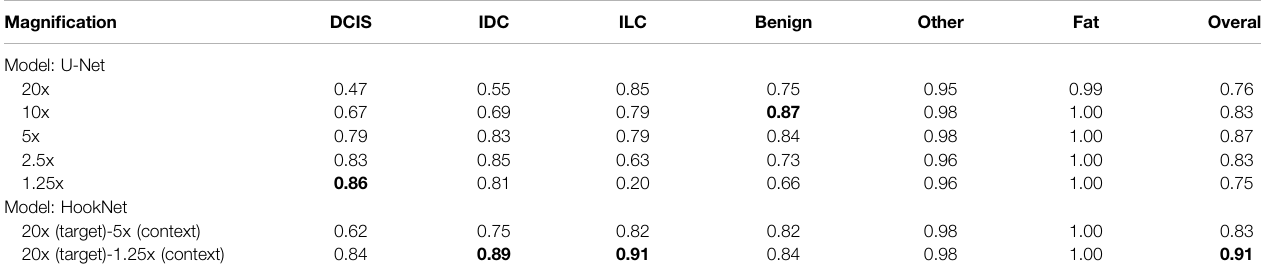
TABLE 5 | Performance of the U-Net (above) and HookNet (below) on the breast dataset. The architectures are compared on the F1 score, for each tissue type (description of the tissue type in the Supplementary Material ). The overall macro-F1 score is reported. The values marked in bold highlight the method that reaches the highest performance, respect to the task.